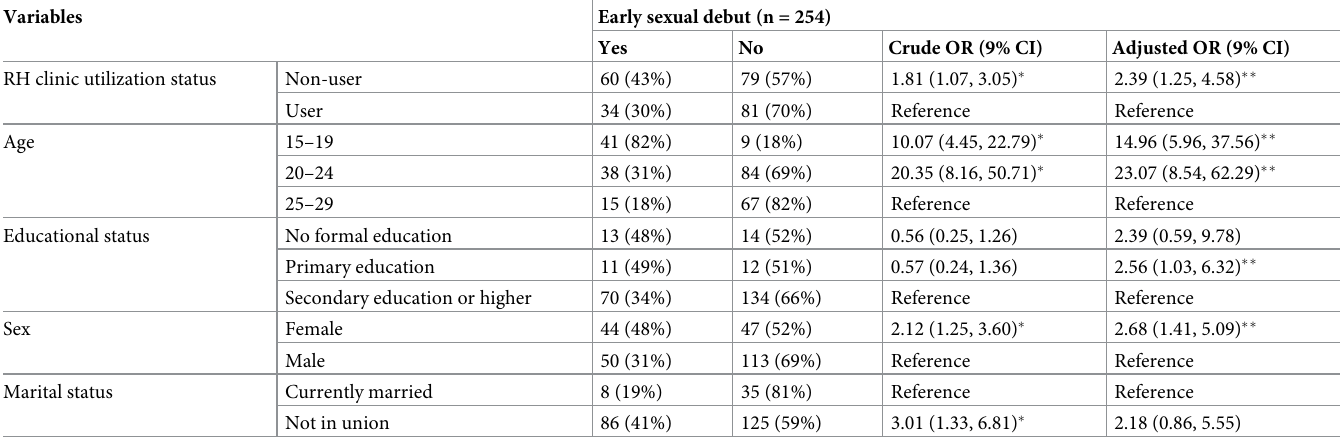
Table 3. Bivariate and multivariable logistic regression analysis of early sexual debut among youth in Addis Ababa, Ethiopia, 2016.